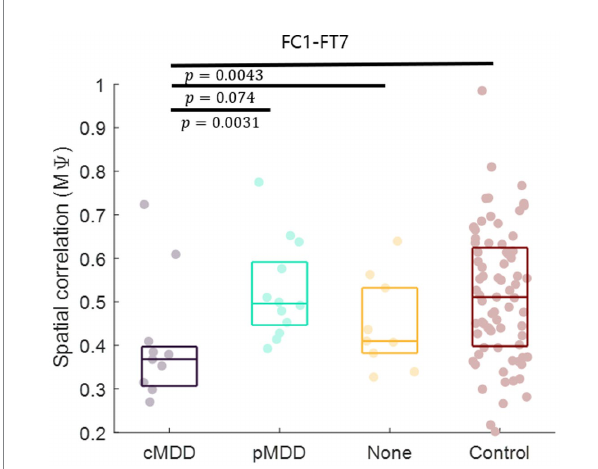
FIGURE 7 Biomarker as the breakdown of inter-hemispheric long-range spatial correlation between left frontal and temporal region of patients with current major depressive disorder. The mean of spatial correlations ( M ψ in Eq. 2) between channels of left frontal and temporal regions. Each dot represents each participant. The three horizontal lines in the box indicate 25, 50, and 75% of the data, respectively. The result of statistical test that the spatial correlation of the left group was lower than the spatial correlation of the right group was displayed as a p -value (rank-sum test).